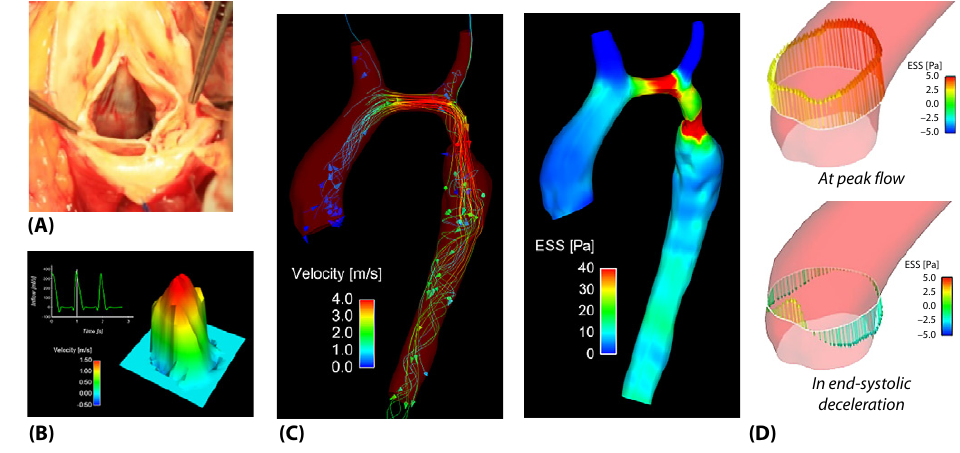
Figure.5 Analysisonabicuspidaorticvalvepatient.(A)aphotographicimagetakenduringoperation,(B)inflow profilesacquiredusingphase-contrastMR,(C)resultsfromcomputationalanalysis(streamlinesandendothelial shear stress map at peak flow) and (D) presentation of the ESS level along a perimeter of ascending aorta, following the method used by Barker et al.